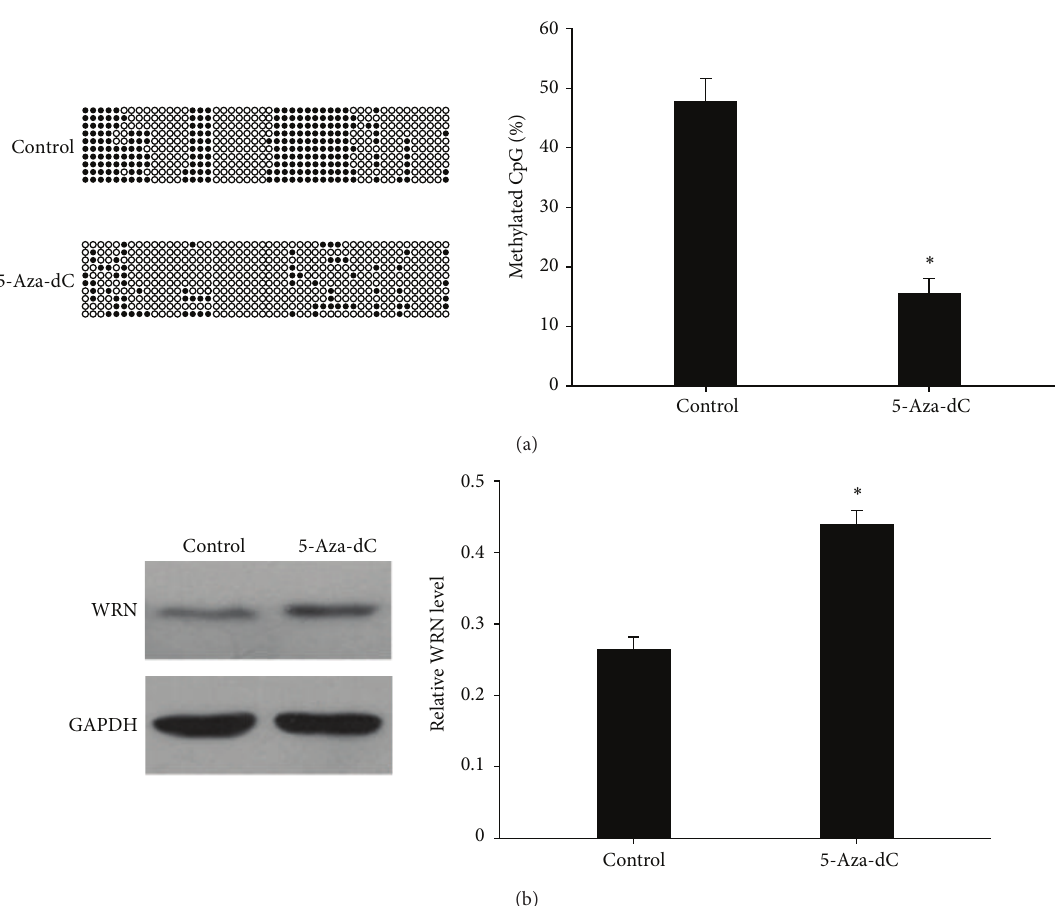
Figure 4: Relative methylation status and expression of protein levels of WRN in HLEB-3 after treatment with 5-aza-dC. In the following panels, each row of circles represents a single clone. Open and close circles represent unmethylated and methylated CpG sites, respectively. (a) After treatment with 5-aza-dC, the methylation rate of WRN in HLEB-3 was decreased. (b) Protein expression of WRN in the untreated control cells and in cells after treatment with 5-aza-dC. Relative WRN protein level to GAPDH is presented as mean ± SD. ∗ 𝑃 < 0.01